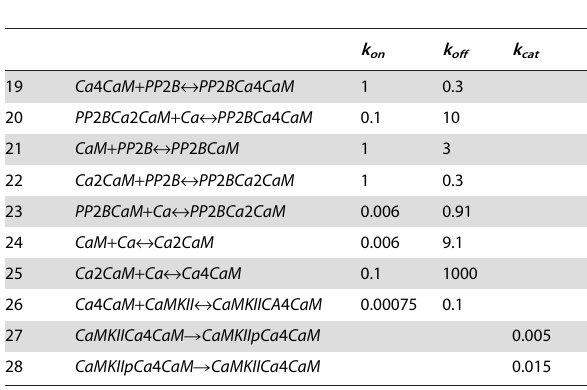
Table 2. Reactions in the Ca